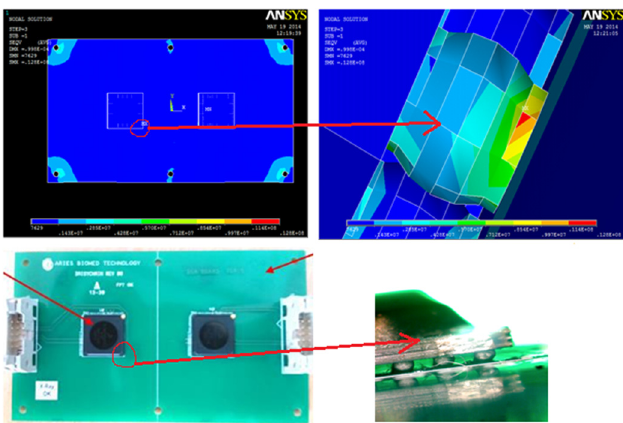
Fig. 15. Failure of solder joint obtained from FE results and experiment.